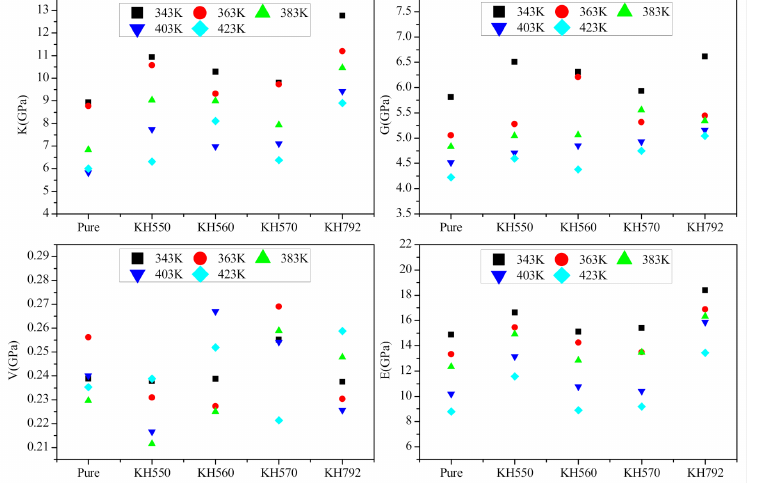
Figure 2. Mechanical parameters of the models.